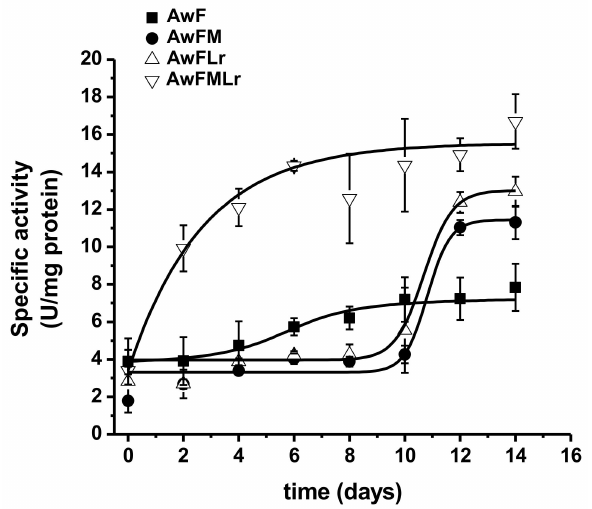
Figure 3. The specific activity of proteolytic